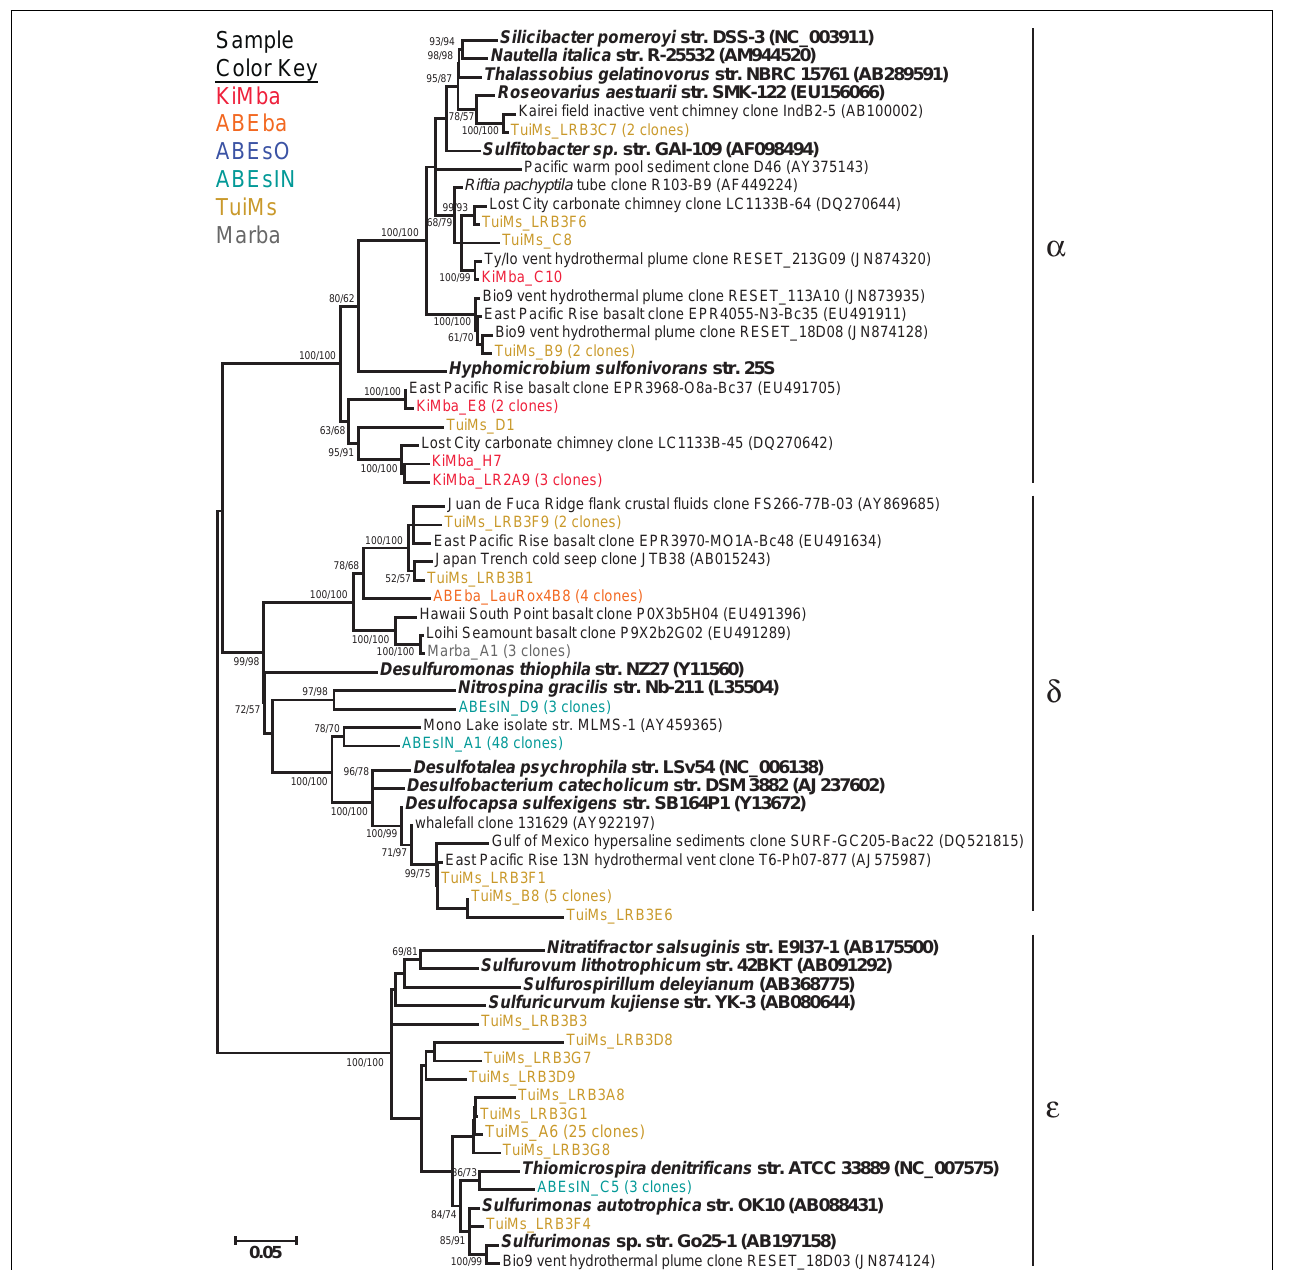
replicates.The same alignment was used to generate a neighbor-joining tree with the maximum composite likelihood method and 1000 bootstrap replicates. Nodes where both methods agree and bootstrap support was > 50% are indicated with bootstrap values from the neighbor-joining tree on the left and the maximum likelihood tree on the right. Samples are color-coded and no representative clones are shared across multiple